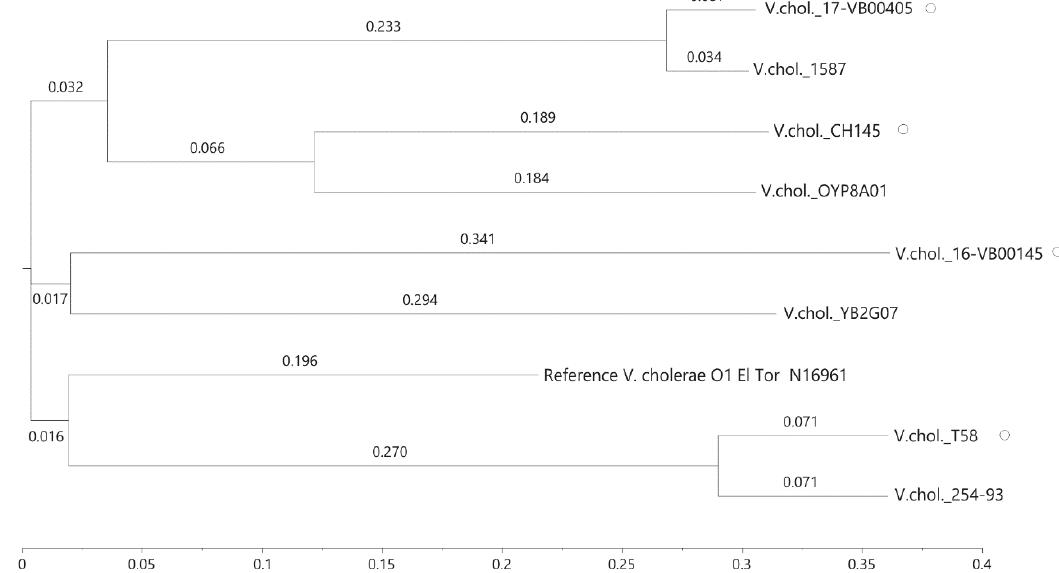
Figure 2. Single nucleotide polymorphism (SNP)-based phylogenetic relationships of V. cholerae non-O1, non-O139 isolates. Strains from ducks are marked with a circle. Four similar genomes of V. cholerae strains identified by bioinformatics were included in the tree. The SNP tree was conducted using CSI Phylogeny 1.4 under default settings and the exclusion of heterozygous SNPs. Single nucleotide polymorphisms (SNPs) were called by mapping to the V. cholerae O1 El Tor N16961 genome as a reference (accession NC_002505.1, NC_002506.1). The scale bar represents the number of nucleotide substitutions per site and numbers indicate branch length. Accession of V. cholerae (V.chol) genomes: LBGA01000000 (YB02G07), JMBP00000000 (V.chol 254-93), KQ410623 (V.chol 1587), NMSW00000000